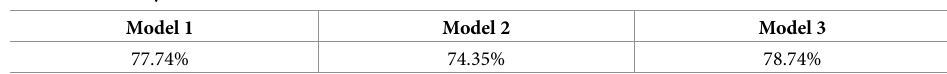
Table 4. Correctly